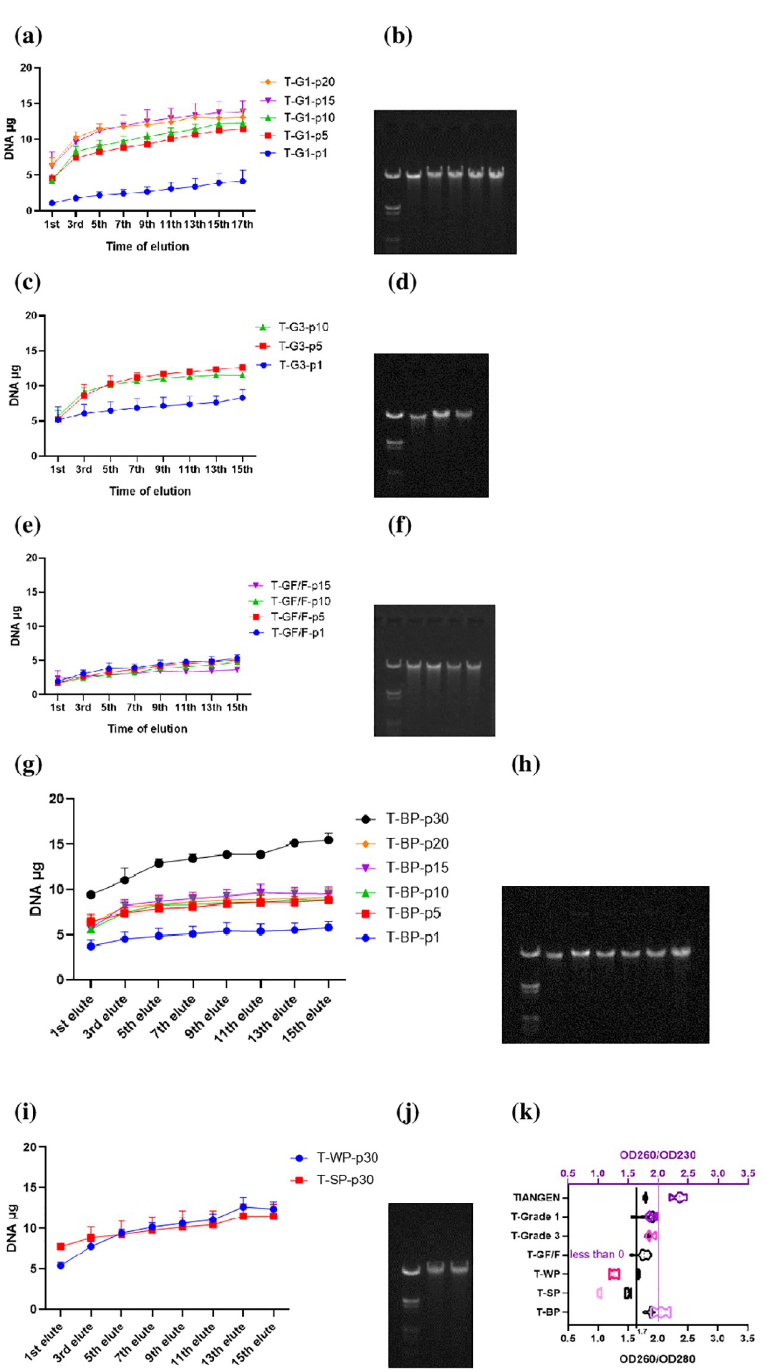
Fig 3. Comparison of the DNA extracting capacities of selected plant fiber-based DNA adsorbents, using the TIANGEN protocol. (a): The quantiy of extracted DNA in different pieces of Whatman ™ Grade 1 filter paper. (b): DNA electrophoresis of related samples (Marker, � T-Grade1-p1, -p5, -p10, -p15, -p20). (c): The quantity of extracted DNA in different pieces of Whatman ™ Grade 3 filter paper. (d): DNA electrophoresis of related samples (Marker, T-Grade3-p1, -p5, -p10). (e): The quantity of extracted DNA in different pieces of Whatman ™ GF/F filter paper. (f): DNA electrophoresis of related samples (Marker, T-GF/F-p1, -p5, -p10, -p15). (g): The quantity of extracted DNA in different pieces of BP. (h): DNA electrophoresis of related samples (Marker, T-BP-p1, -p5, -p10, -p15, -p20, -p30). (i): The quantity of extracted DNA in 30 pieces of WP and SP. (j): DNA electrophoresis of related samples (Marker, WP, SP). (k): The OD260/OD280 (black) and OD260/OD230 (purple) purity ratios of related samples. � T and p refers to TIANGEN protocol and the number of the adsorbent pieces used, respectively.